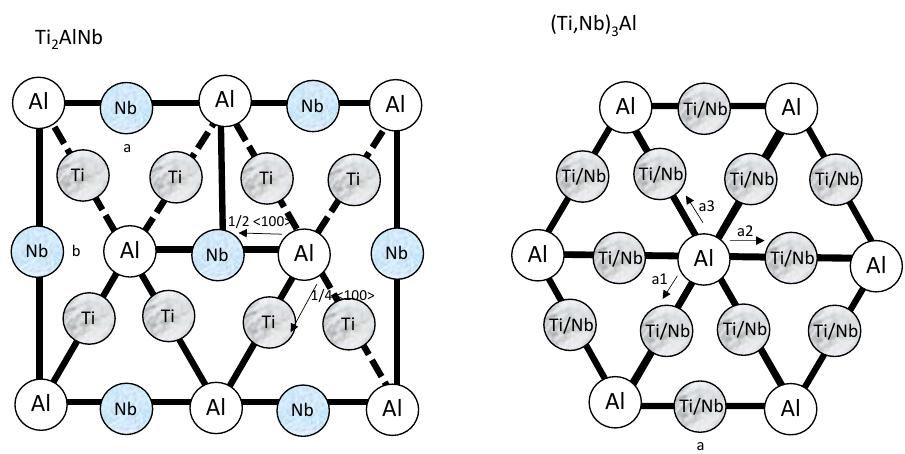
Figure 1. Arrangement of Nb and Ti atoms in network cells (diagrams were elaborated based on Reference [8]).